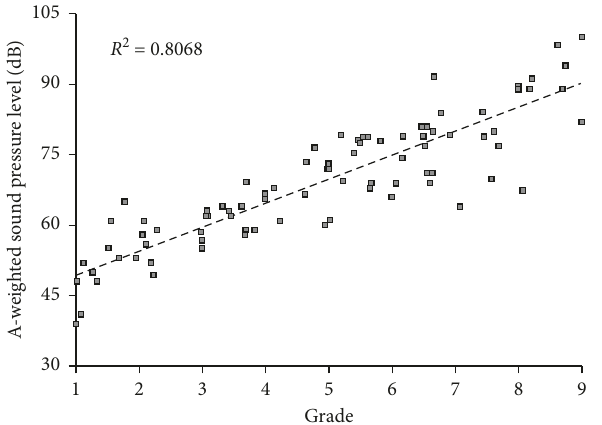
Figure 6: Correlation between A sound level and evaluation score.